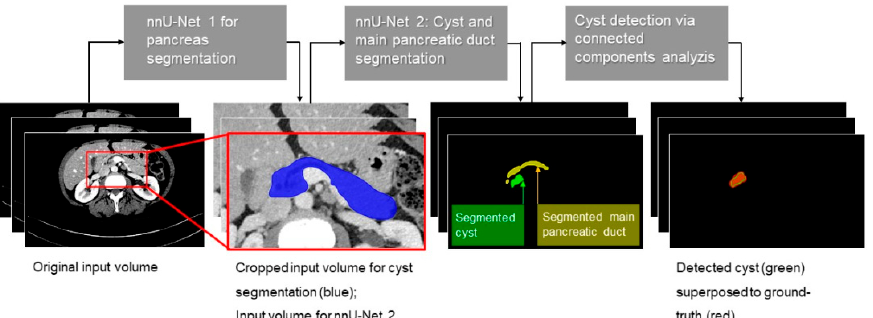
Figure 2. Structure of our segmentation approach. First, the original input volume was cropped based on the automatic segmentation of the pancreas with a first nnU-Net. PCLs and MPDs were then manually segmented on the cropped volume to create a ground truth. The trained algorithm detected cysts. The image on the right shows the resulting cyst detection superposed to the ground truth.